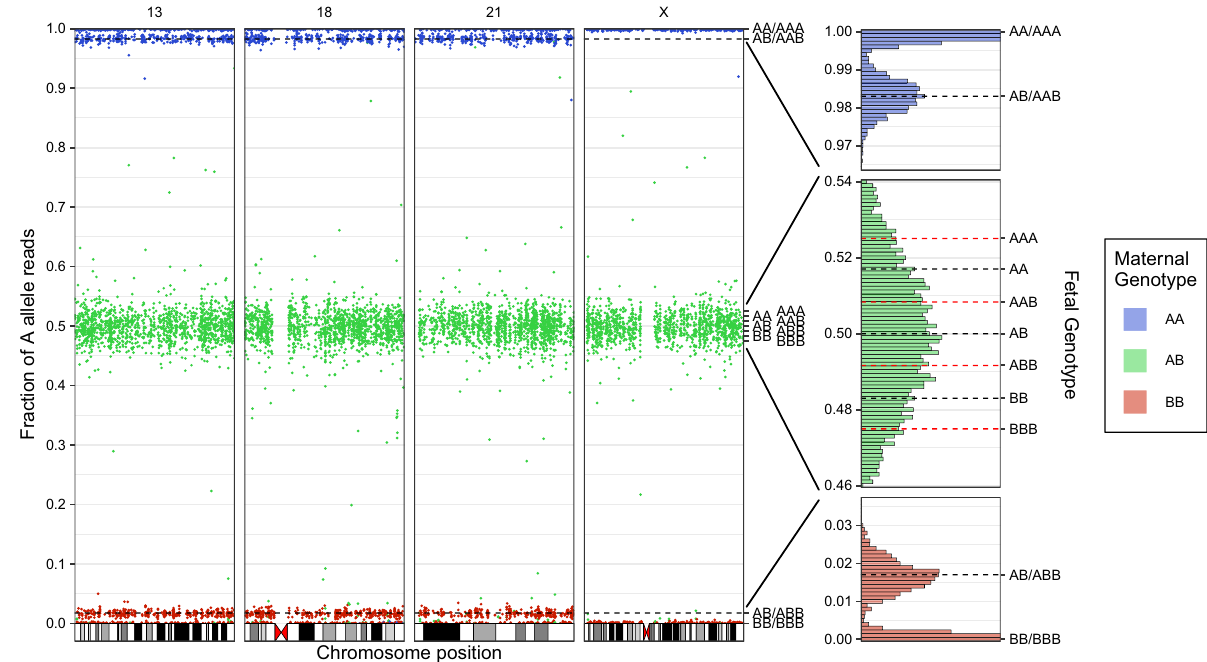
Figure 4. SNP-based targeted sequencing data without chromosomal phase. Graphical representation of sequencing data from the SNP-based targeted sequencing of maternal plasma obtained from the pregnant mother at 11 weeks GA with a fetal DNA fraction estimated as f = 3.4%. Points correspond to the fraction of alternate (A) allele read counts as a fraction of the overall number of reads at SNP loci sampled by more than 200 sequence fragments. At loci for which the mother is homozygous, the fetal genotype can be inferred with high accuracy. Black and red dotted lines represent the expected fractions of A alleles for different combinations of maternal and fetal genotypes in the case of, respectively, a euploid and trisomic fetus. The lack of SNP loci at fractions for which the mother is expected to be homozygous and the fetus is expected to be heterozygous along the chromosome X homologs is indicative of a male